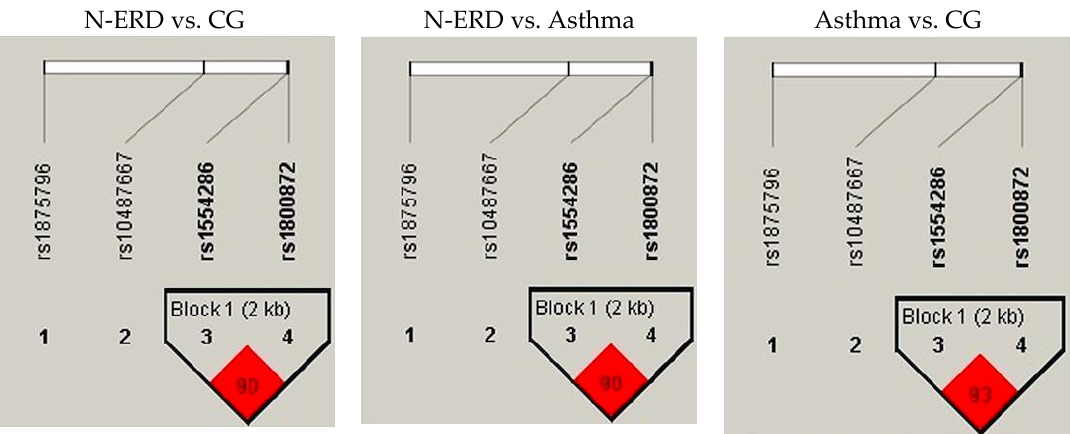
Figure 2. Haplotype analysis of IL10 (rs155286 and rs1800872). N-ERD: non-steroidal anti-inflammatory drugs exacerbated respiratory disease. CG: control group.